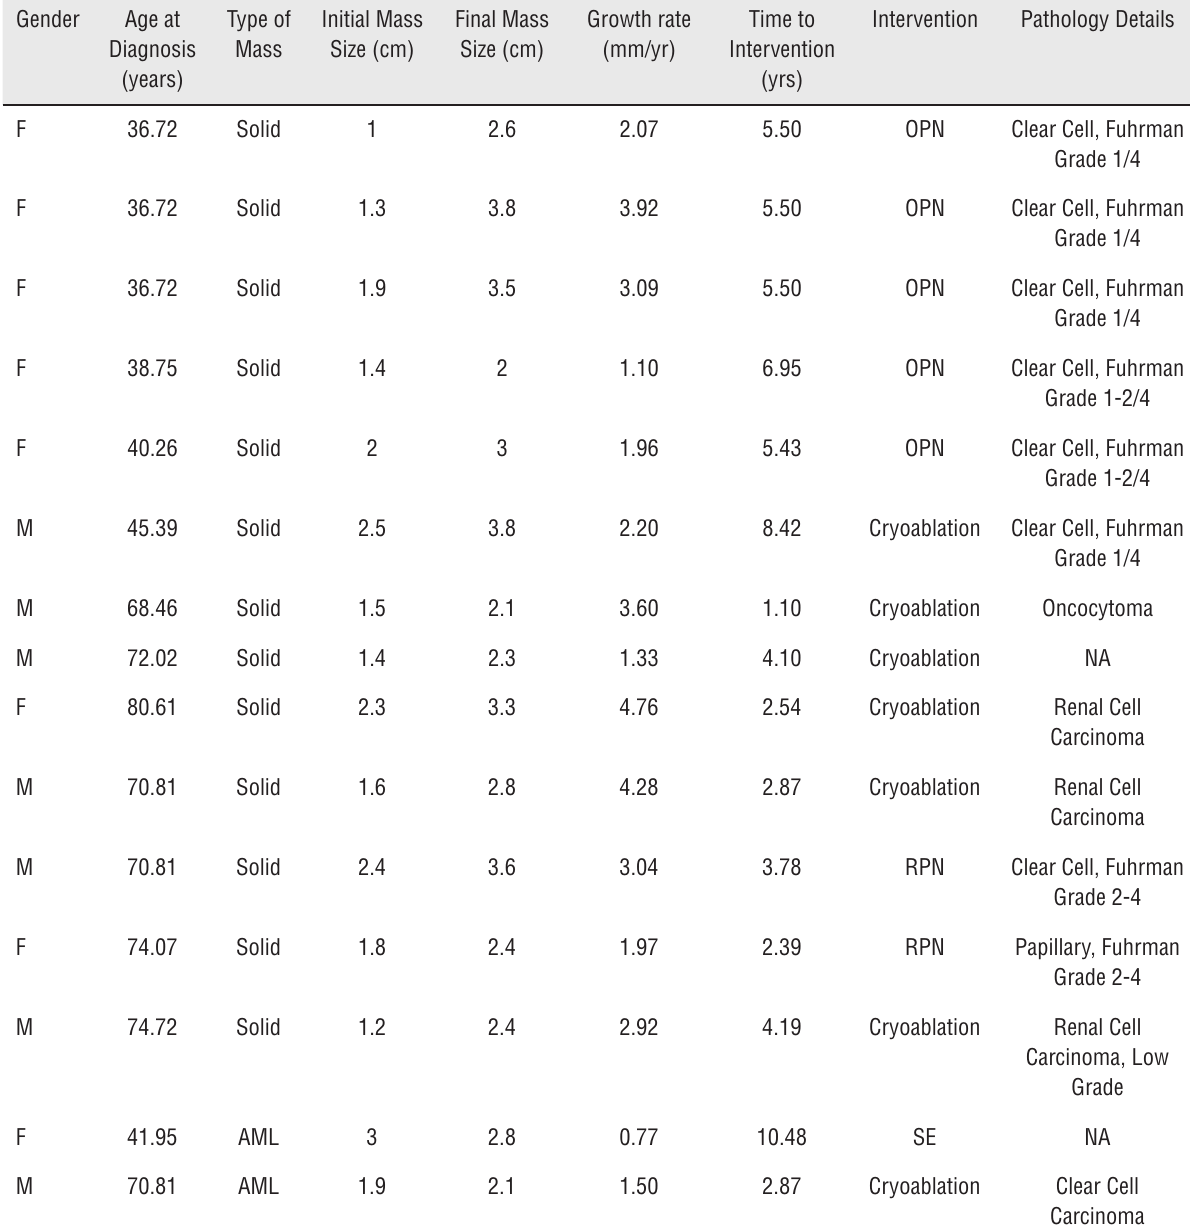
Table 2 - Renal masses under AS which progressed to surgical